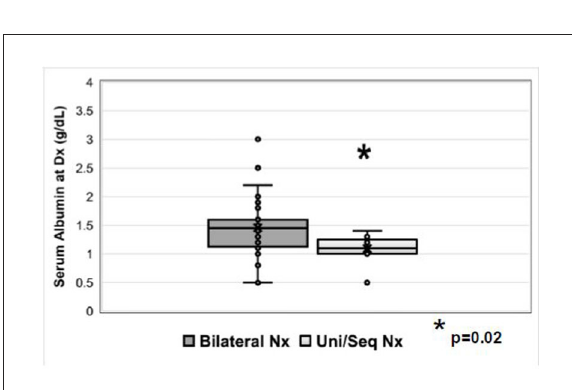
FIGURE3 Serum albumin (g/dL) at the time of diagnosis in patients who underwent bilateral nephrectomy or unilateral/sequential nephrectomy. Nx =